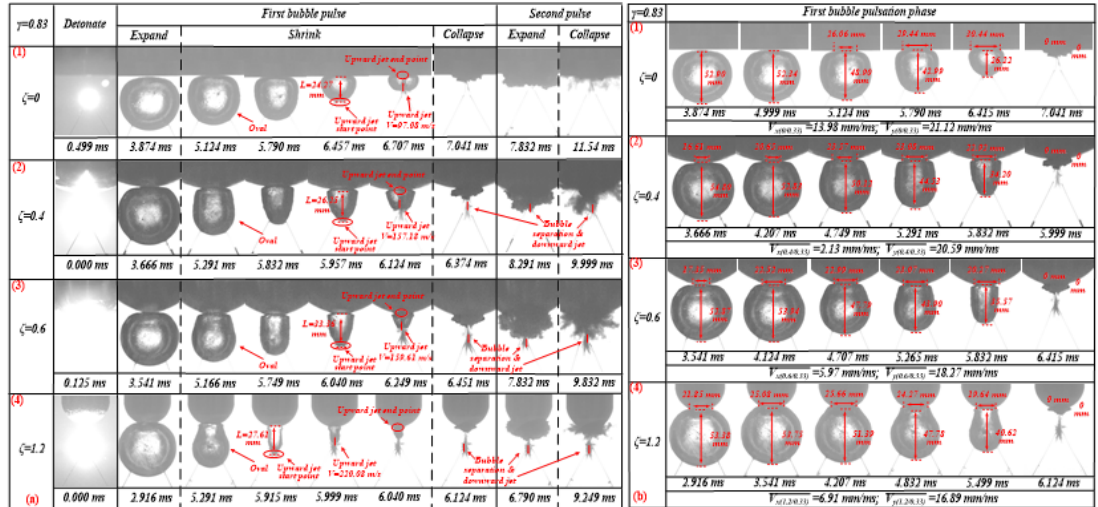
Figure 11. ( a ) The bubble’s morphological changes under the influence of di ff erent ζ values. The first row shows the bubble’s morphological changes when ζ = 0 and γ = 0.83. The second row shows the bubble’s morphological changes when ζ = 0.4 and γ = 0.83. The third row shows the bubble’s morphological changes when ζ = 0.6 and γ = 0.83. The fourth row shows the bubble’s morphological changes when ζ = 1.2 and γ = 0.83. ( b ) The bubble’s contraction speed under the influence of di ff erent ζ values. The first row shows the bubble’s contraction speed when ζ = 0 and γ = 0.83. The second row shows the bubble’s contraction speed when ζ = 0.4 and γ = 0.83. The third row shows the bubble’s contraction speed when ζ = 0.6 and γ = 0.83. The third row shows the bubble’s contraction speed when ζ = 1.2 and γ = 0.83.